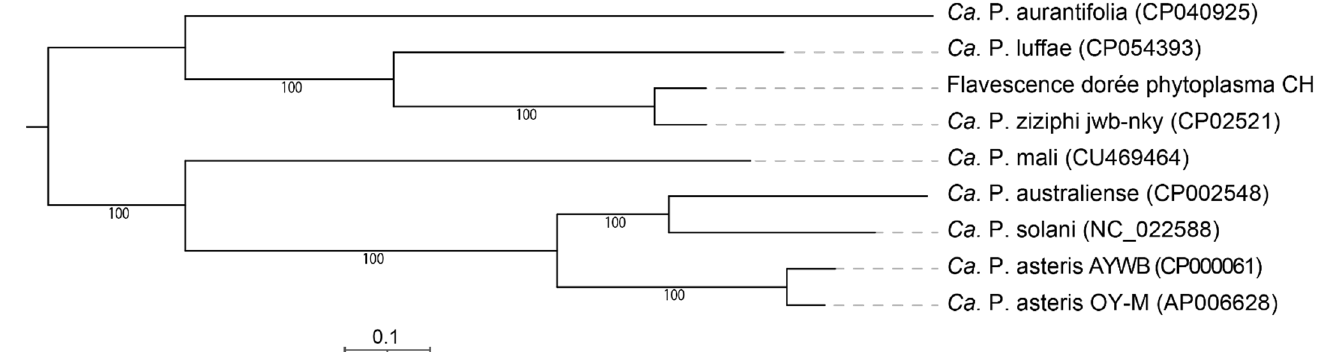
Figure 6. Maximum likelihood phylogeny inferred using 203 single-copy orthologue genes; the concatenated alignment contains 70,619 aligned amino acid sites. The numbers on branches indicate the level of bootstrap support (1000 replicates). Support values above 80% are labeled. The scale bar shows the number of substitutions per site. Table 3. Pairwise genome comparisons.